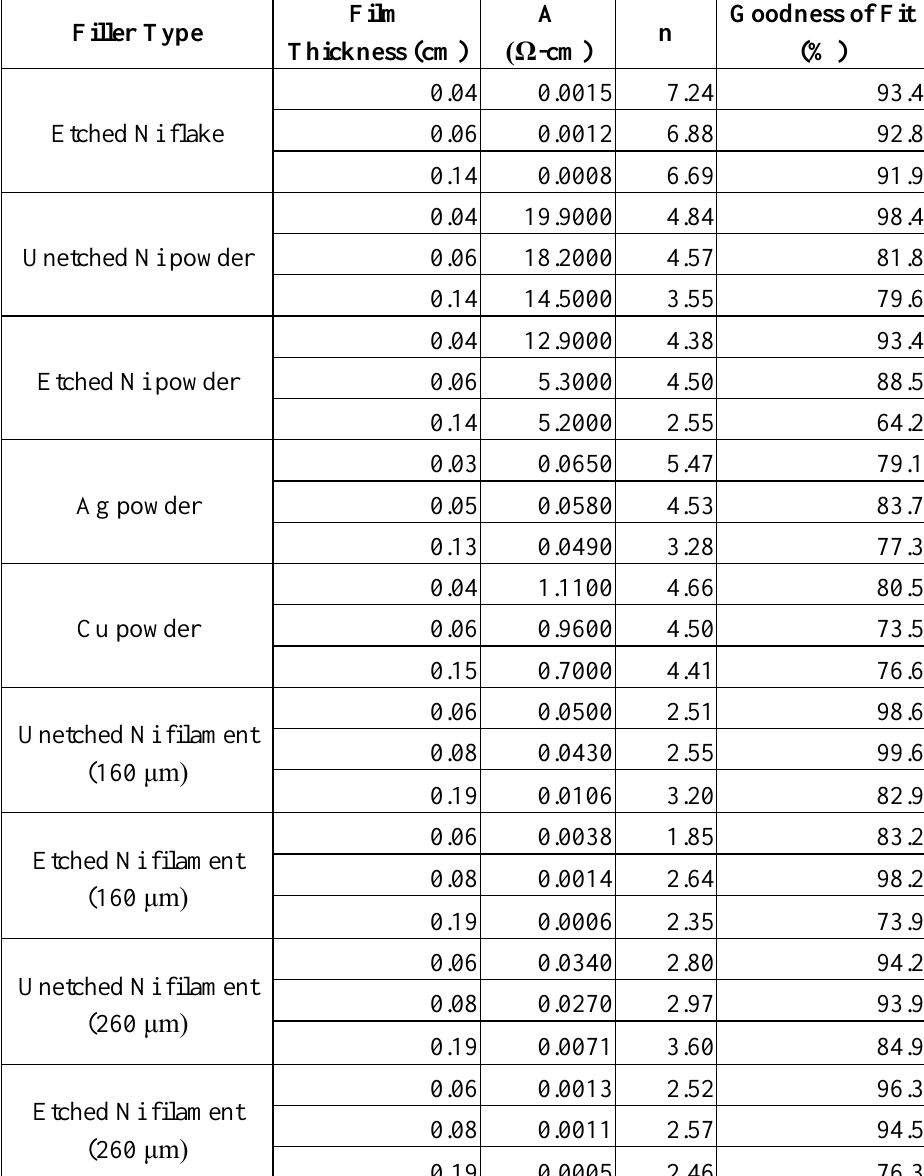
Table 3. The material parameters of the 2-parameter power function  = A/  n , describing the volume fraction (  )-dependent conduction behavior with various conductive particles in Epon 815C